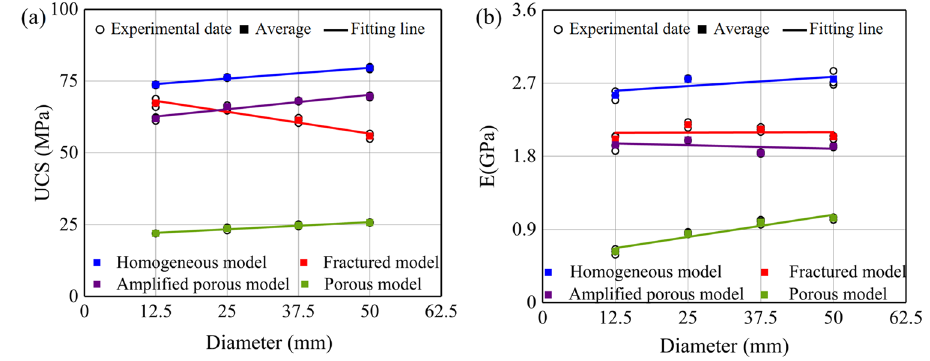
Fig. 8 Comparison of uniaxial compression mechanical properties of four types of printed models at varied scale sizes. a UCS and b Elastic modulus